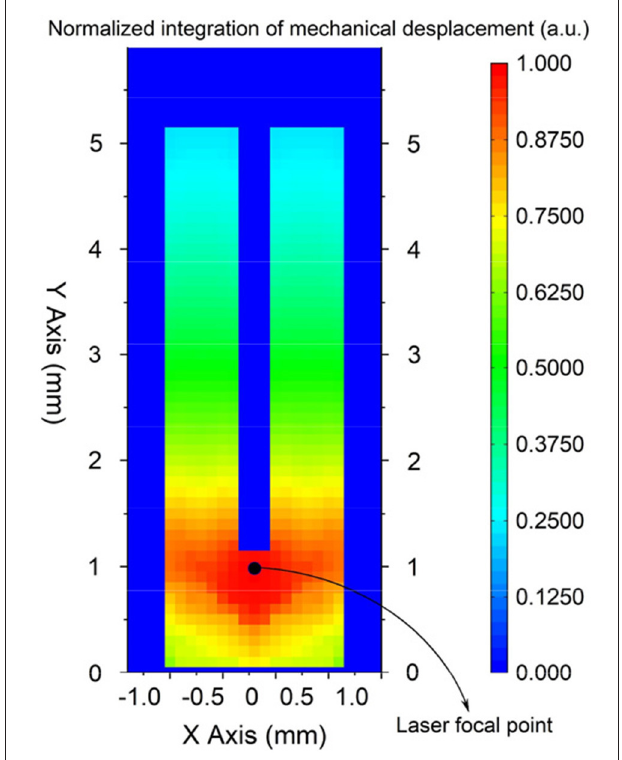
FIGURE 12 | The normalized integration for photothermal effect induced two prongs mechanical displacement of the QTF’s surface. Reprinted with permission from [ 99] © The Optical Society.